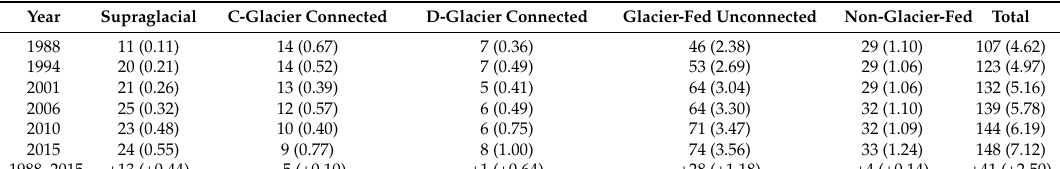
Table 5. Inventory of glacial lakes in various types at six time points between 1988 and 2015 (units: count (area, km 2 )).